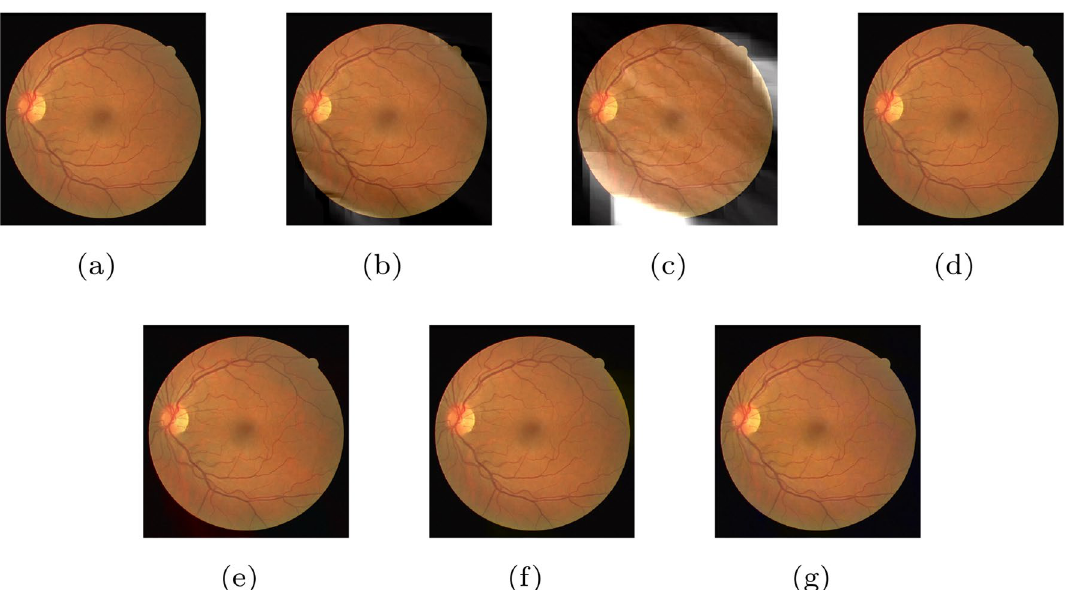
Figure 4. ( a ) The original image. ( b ) The reconstructed image with salt and pepper noise added to the component Y S . ( c ) The reconstructed image with salt and pepper noise added to the component Y D . ( d ) The reconstructed image with salt and pepper noise added to the components U S . ( e ) The reconstructed image with salt and pepper noise added to the component U D . ( f ) The reconstructed image with salt and pepper noise added to the component V S . ( g ) The reconstructed image with salt and pepper noise added to the component V D